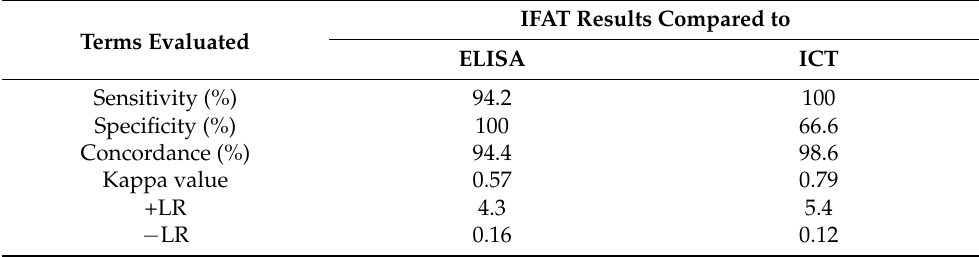
Table 4. Overall results of ELISA and ICT for detection of antibodies to B. bovis in field serum samples compared with those of